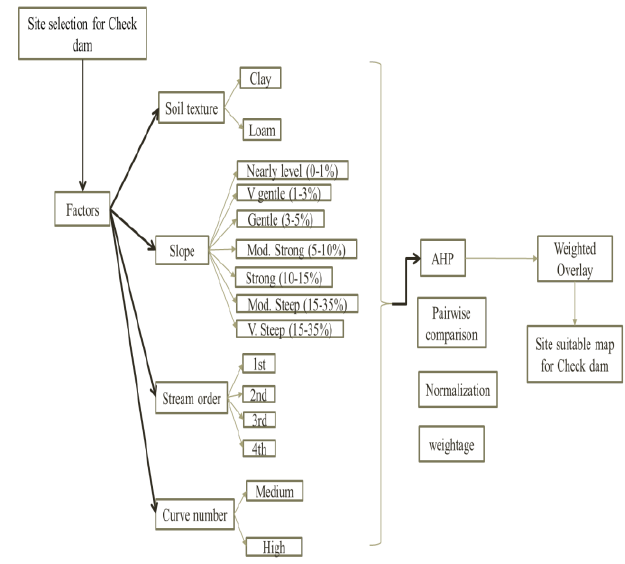
Figure 2 Overall methodology